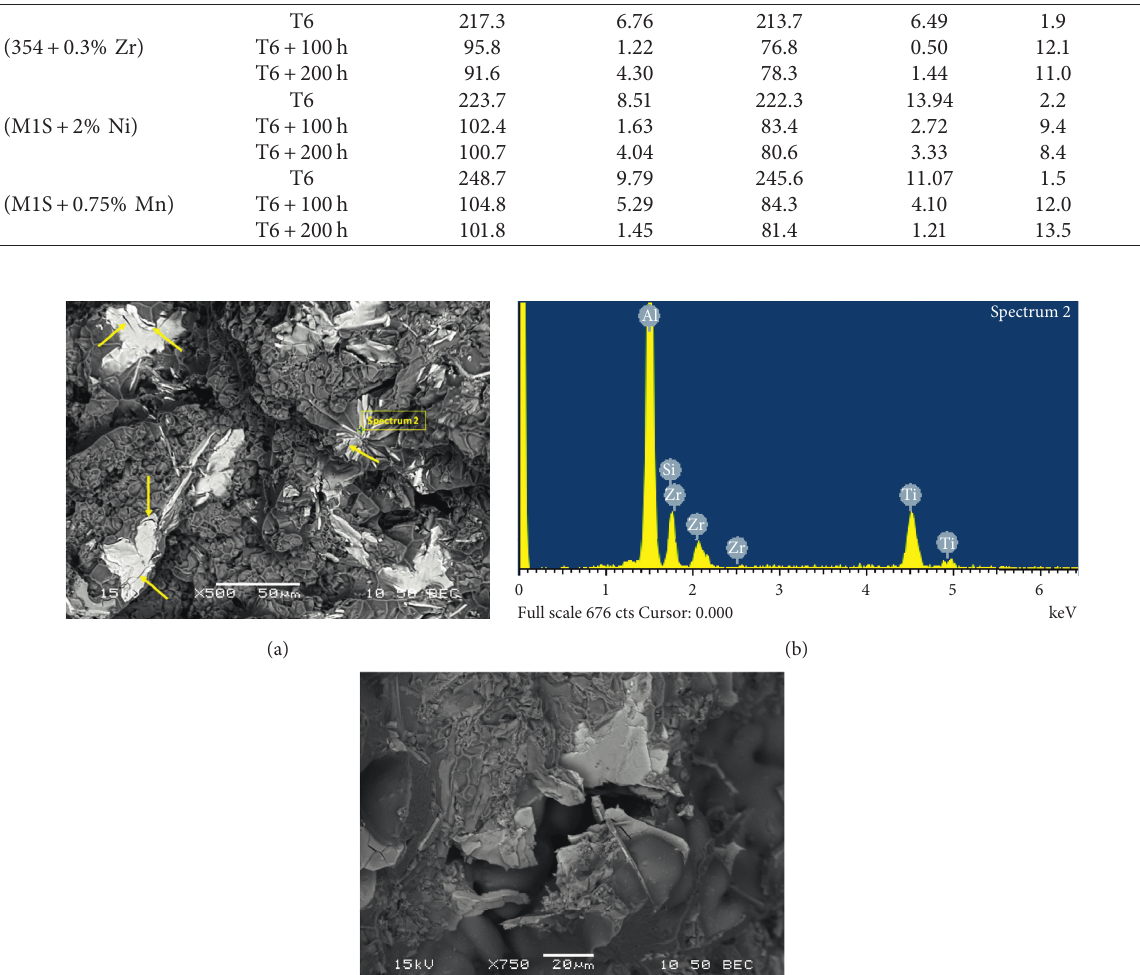
Table 2: Tensile properties of the three used alloys tested at 250 ⁰ C. Alloy